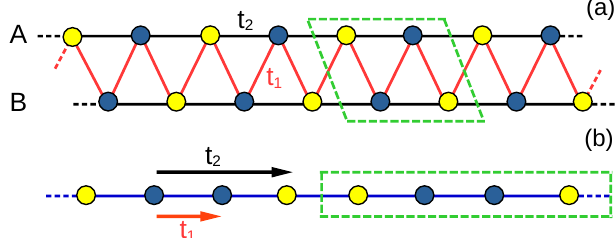
Figure 1: (a): Pictorial description of the zigzag ladder considered in the main text. The indices A and B stand for the two legs of the ladder. The red and black lines represent the NN (inter-leg) and NNN (intra-leg) bonds with hopping strength t t , respectively. The dashed lines indicate the bonds which connect the ladder across 2 the boundary. Lattice sites denoted by yellow (blue) circles admit on-site potential − W ( W ) . (b): Mapping of the zigzag ladder to a 1D chain. The unit cells in both lattices are highlighted by green dashed